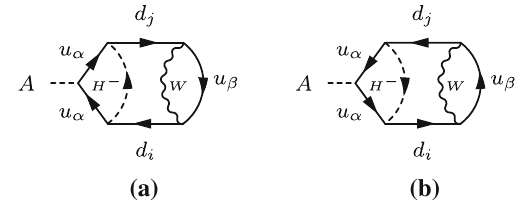
Fig. 3 Example of pair of Feynman diagrams where J factorizes (for fixed α,β, i , j ). They differ only by the direction of fermion flow (or equivalently by the exchange of the two down-type quarks, d i ↔ d j